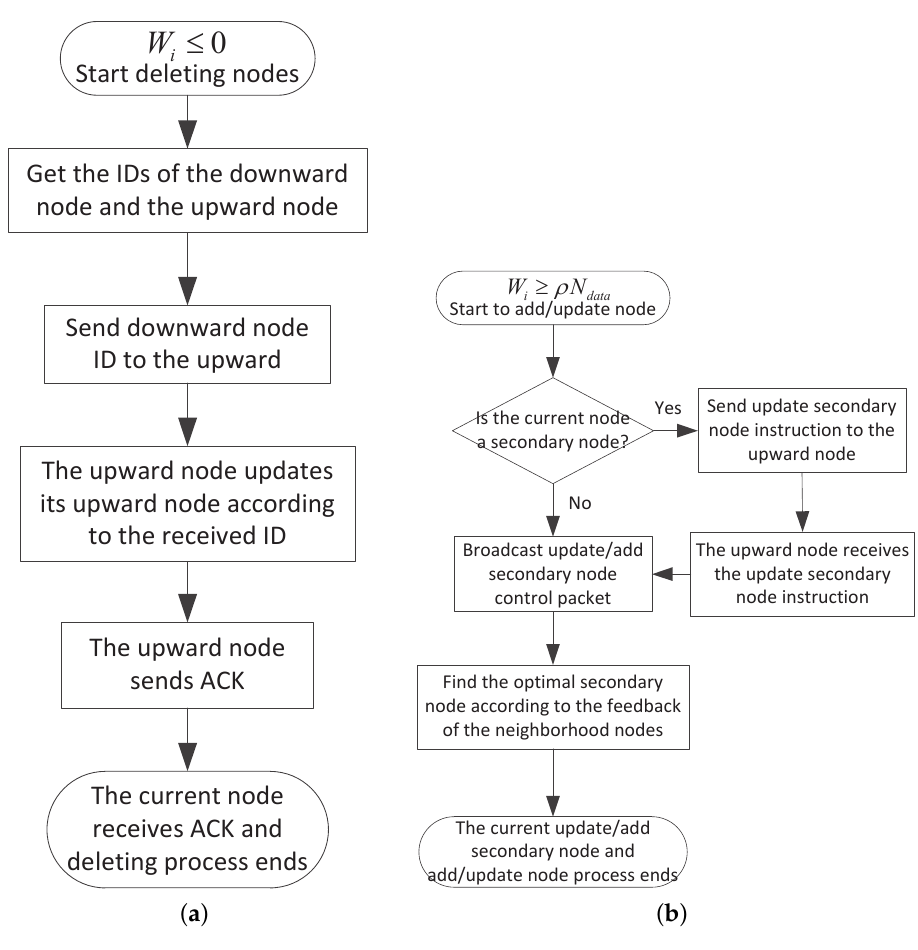
Figure 5. ( a ) The process of deleting nodes; ( b ) The process of adding/updating